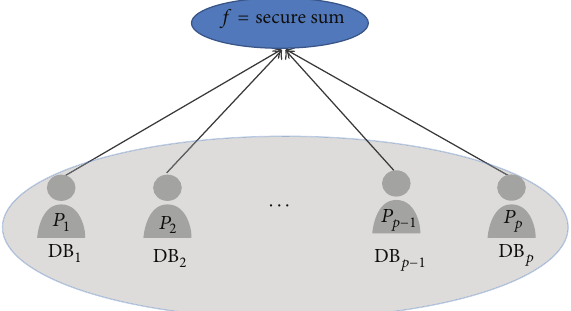
Figure 1: Semihonest adversary model for secure sum in